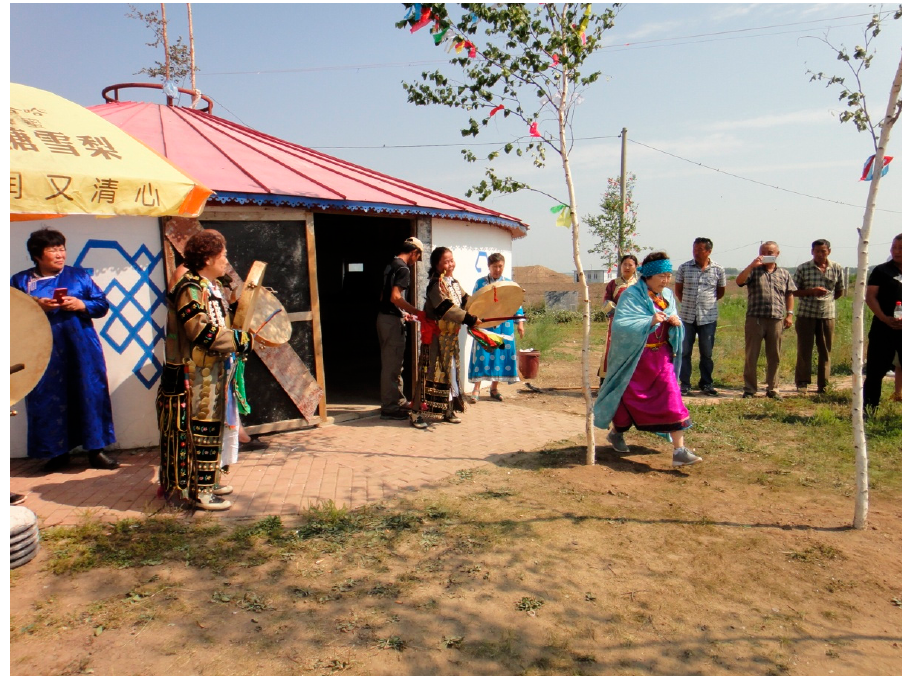
Figure A4. Candidates ran along the nine white birch trees—to lead the bar ʃ ancestor’s ʊ ŋ ɡ ʊ r Shaman Siqingua and Wo Jufen were drumming for cheer (On 8 July 2015, Wo Liming’s initiation ritual as bar ʃ ). Photo: Minna Sa, 2015.